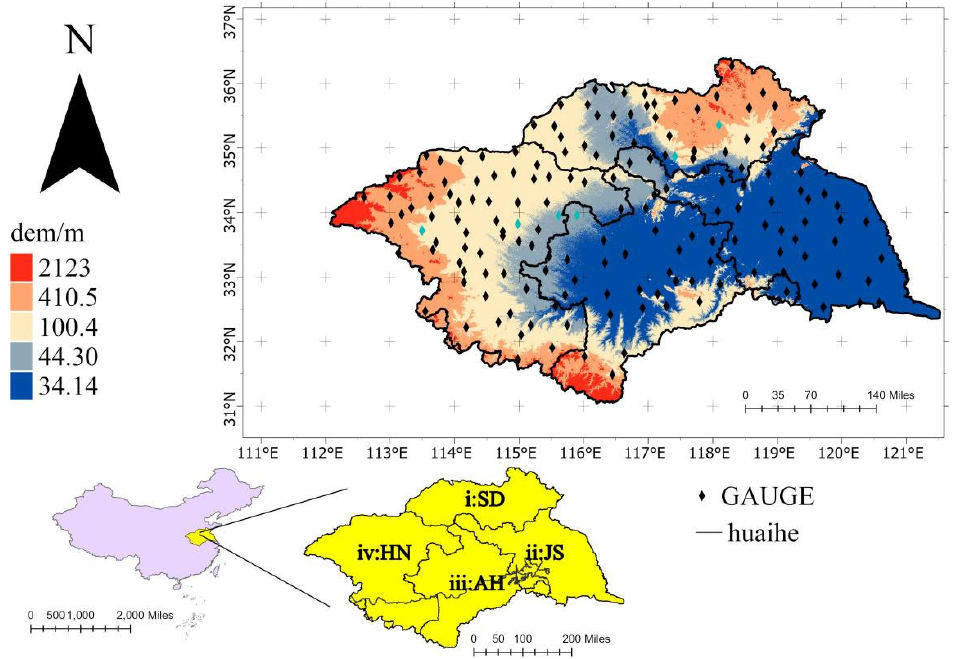
Figure 2. Digital Elevation Model (DEM) map of the Huaihe River basin and meteorological stations.